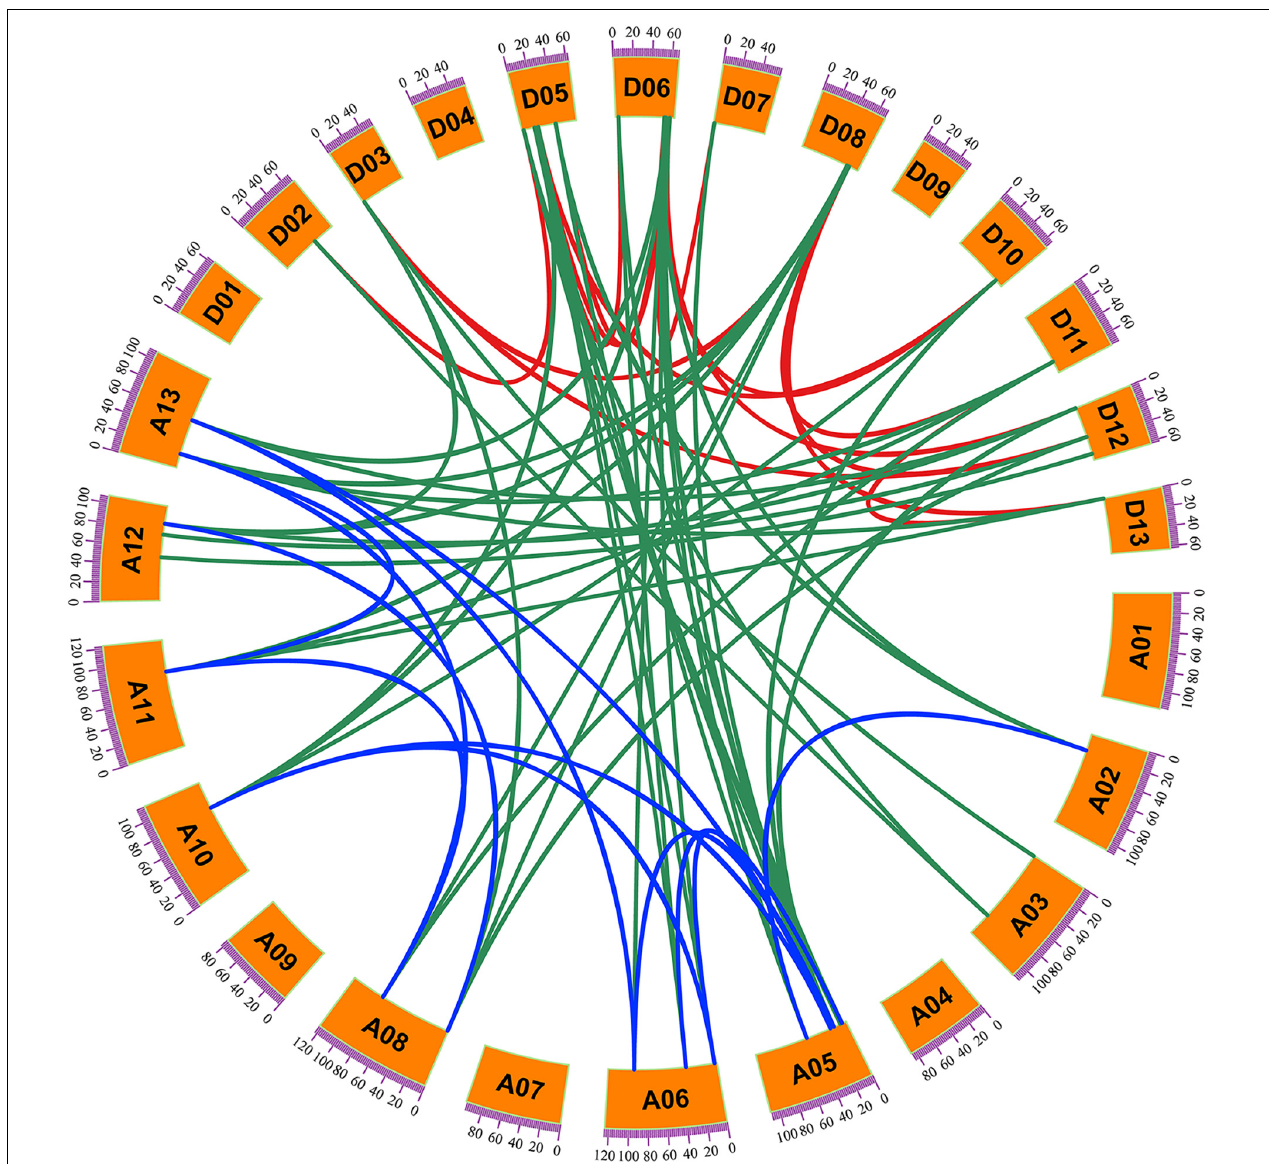
FIGURE 4 | Collinearity analysis of KNOX genes on G. hirsutum chromosomes. Green lines link two homoeologous genes located in the A and D subgenome chromosomes. Red and blue lines link the two homologs formed by segmental duplication within the D subgenome and A subgenome, respectively. A01–A13 indicate the chromosomes in the A subgenome and D01–D13 indicate the chromosomes in the D